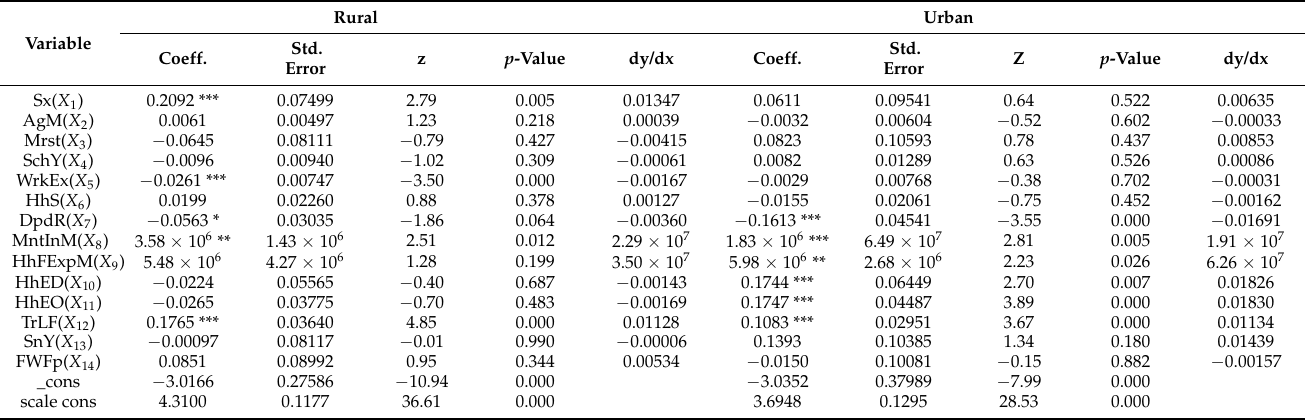
Table 5. Beta regression